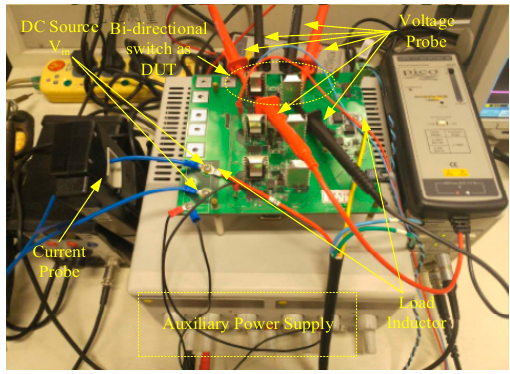
Figure 12. Photo of the built SiC JFET-based double-pulse test setup.